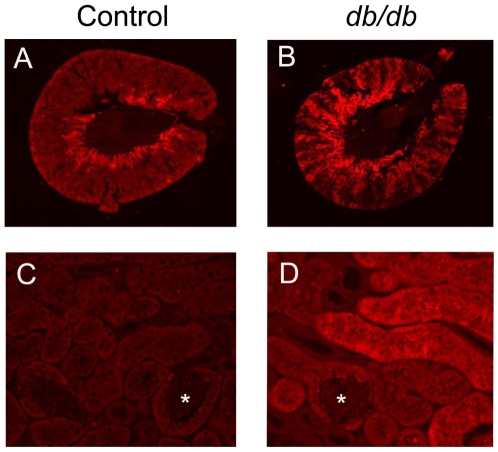
Immunohistochemical staining of RALDH1.Representative 5 µm formalin-fixed sections of kidney are shown from control (panels A and C) and db/db (panels B and D) mice. Panels A and B are low magnification images of the entire kidney section scanned using the LI-COR Bioscience Odyssey™ Imaging System while higher power confocal images are shown in Panels C and D. Negative controls included omitting the primary antibody, rabbit monoclonal anti-RALDH1 from Novus Biologicals (data not shown). Asterisks indicate glomeruli. Magnification for panels C and D, 300×.